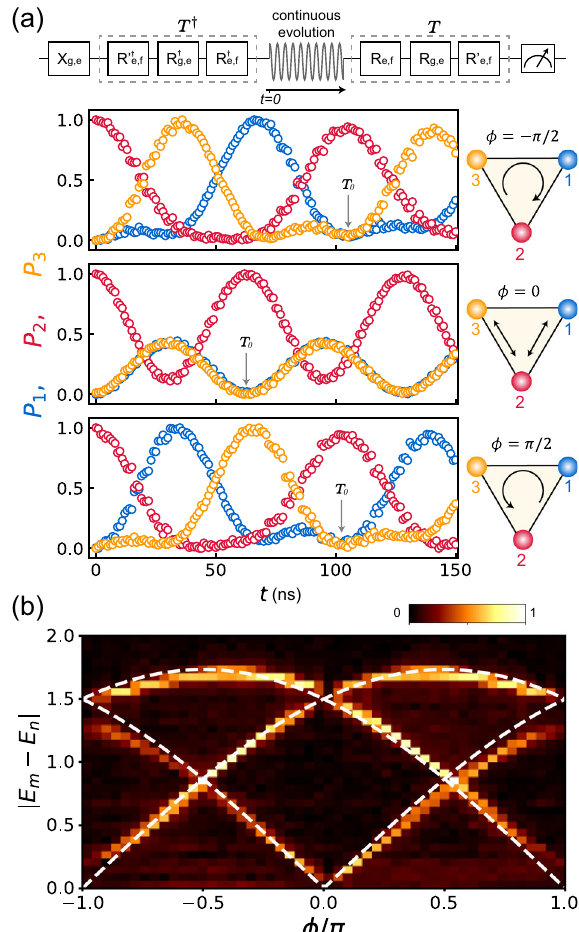
Fig. 2 Phase-controlled quantum dynamics resulting from CCI in a single qutrit. a Upper part: fl owchart of the experiment, including a block for initialization ( X g , e ), a digital module of T † composed of three gate operations, an analog module of the natural evolution driven by H 0 , and another digital module T , followed by projection measurements that yield the three populations of P 1,2,3 . Both ramp- negligible since observing the CCI and analyzing the related physics require a time scale much longer. Lower part: P 1,2,3 as functions